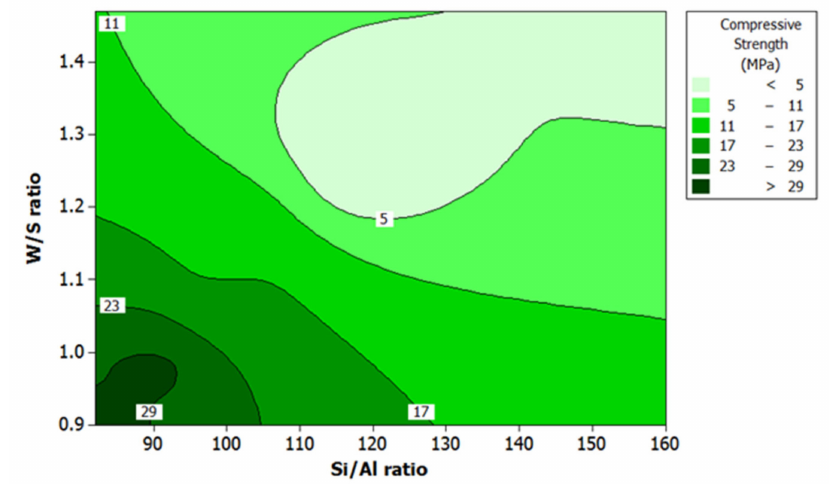
Figure 6. Contour plot of compressive strength, W/S ratio, and Si/Al